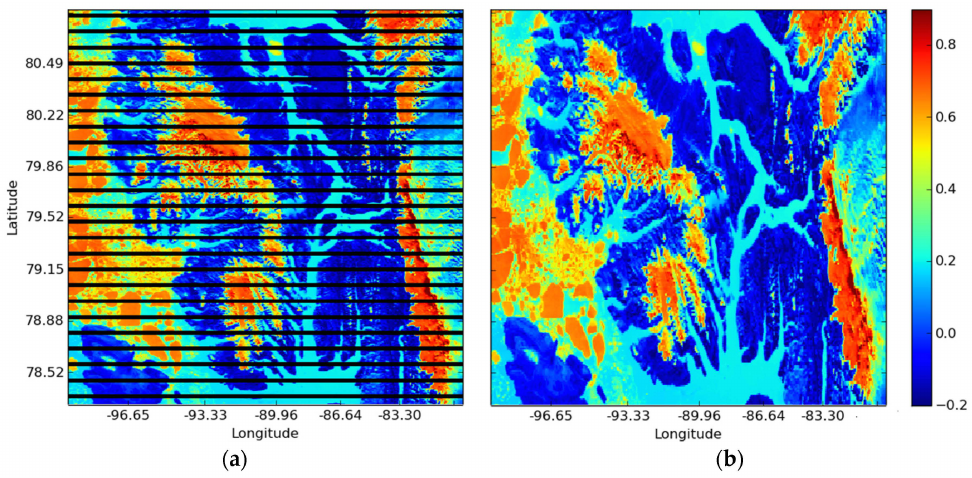
Figure 15. ( a ) Difference between original M4 (0.55 µ m) and M10 (1.6 µ m) bands; ( b ) difference between resampled M4 and M10.